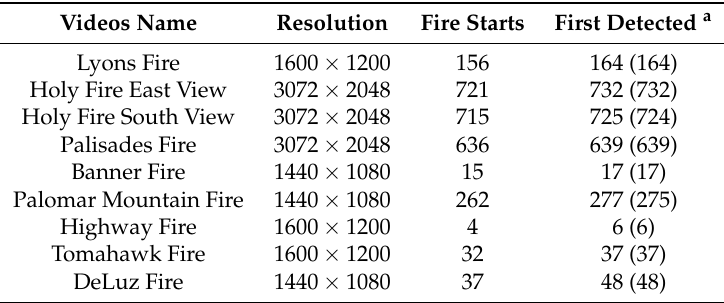
Table 2. Daytime Fire Result of HPWERN